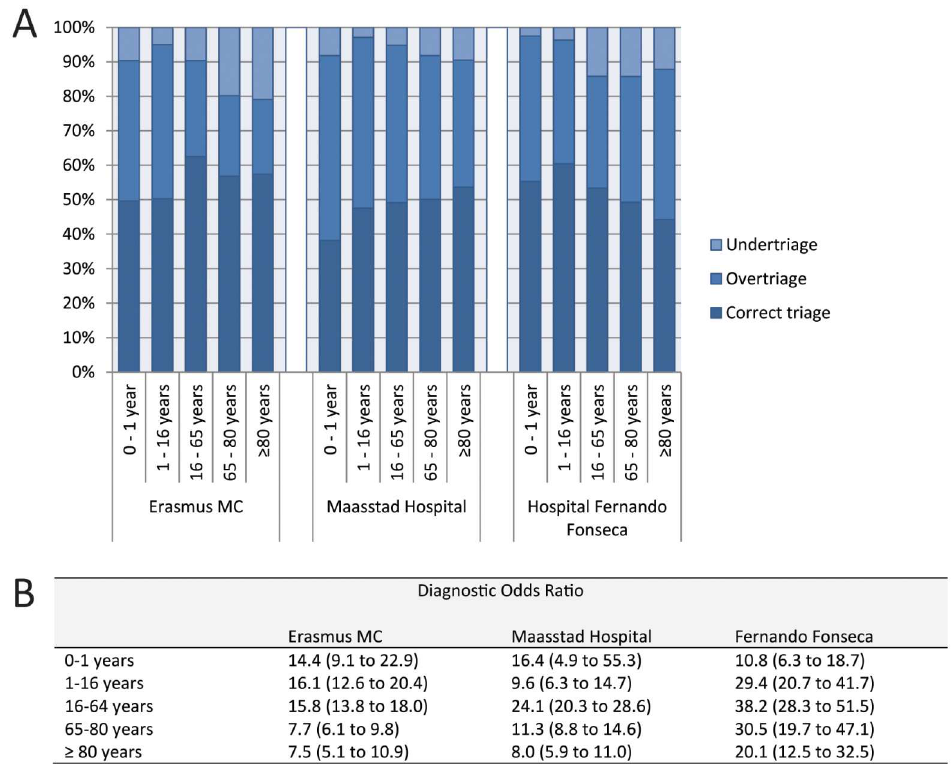
Fig 1. Performance of the MTS in different age groups. A) percentages under-, over-, and correct triage; B) diagnostic odds